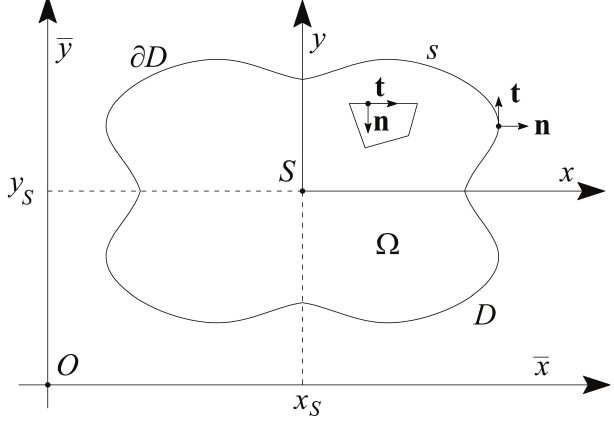
Figure 5. Cross-section with